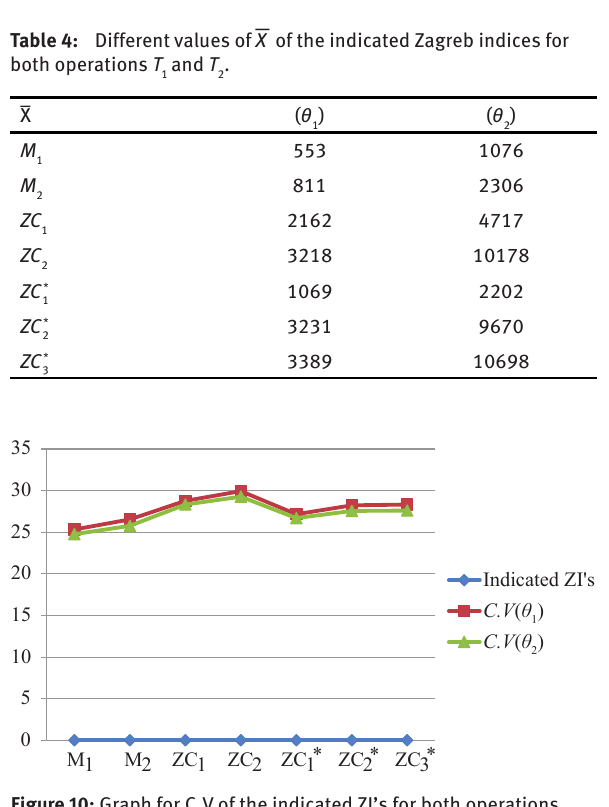
Figure 10: Graph for C.V of the indicated ZI’s for both operations T and T based on Table 3 1 2